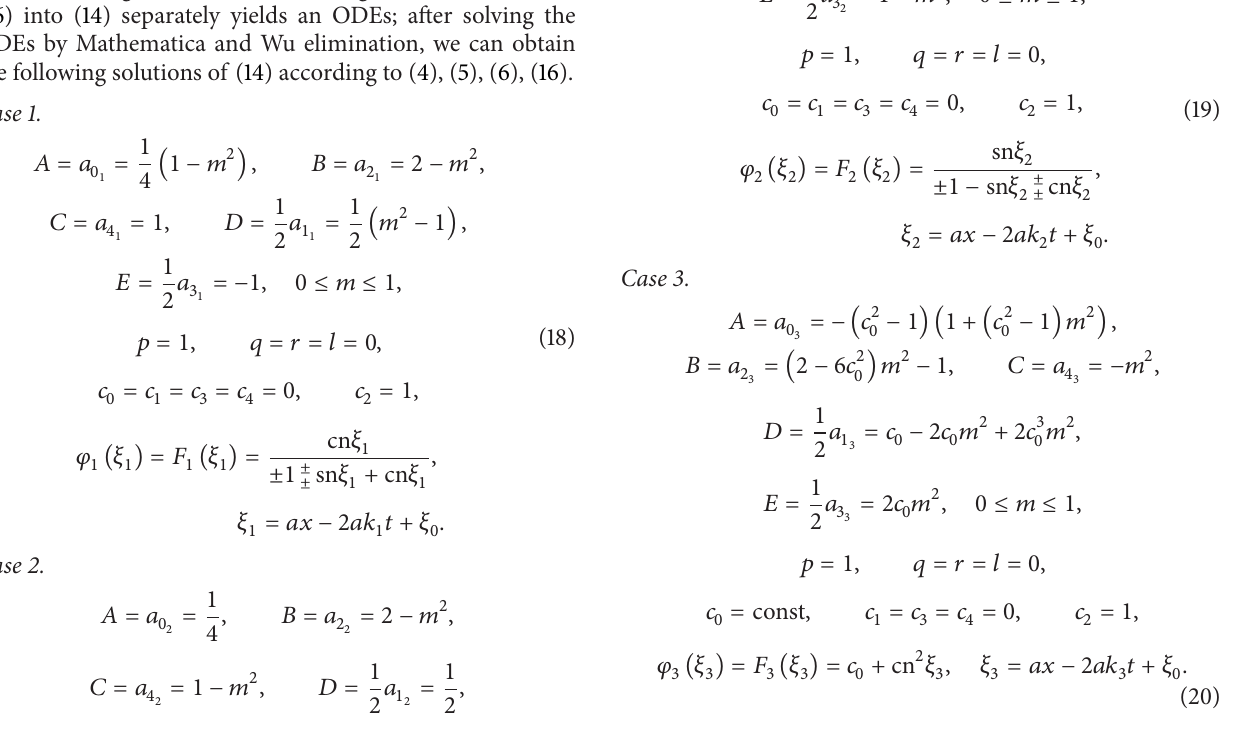
Figure 2: The imaginary part of 𝐸 6 when 𝑎 = 𝛼 = 1, 𝛽 = −1, 𝜉 0 = 0 , and 𝑚 = 0.9 and a plane graph when 𝑡 = 0 . Substituting (4), (5), (6), (7) along with (8a)–(8d)